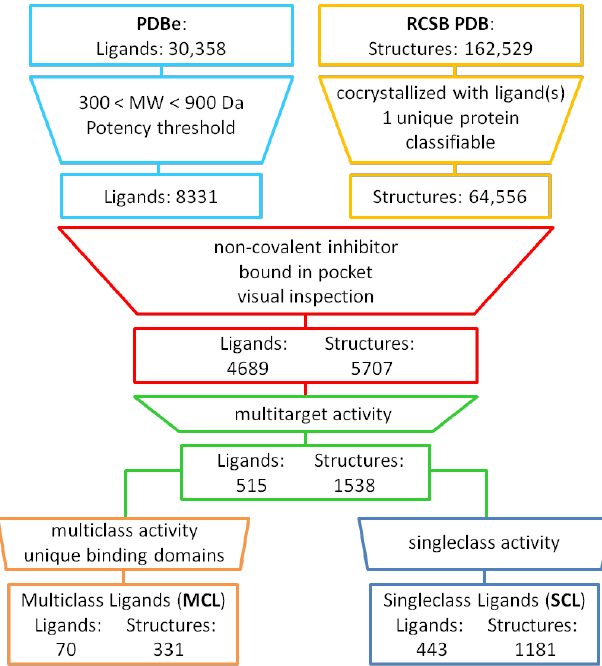
Figure 1. Large-scale data analysis scheme. Ligands from X-ray structures were filtered for criteria such as molecular weight, minimum potency, and (bio) chemical characteristics. X-ray structures of classified proteins in complex with qualifying ligands were analyzed for non-covalent binding events. Ligands binding to multiple targets from the same protein class (single-class ligands, SCLs) and from different classes (multiclass ligands, MCLs) were identified. Two of 72 originally assigned MCLs were found to bind exclusively to very similar domains in different proteins and were thus not further analyzed.